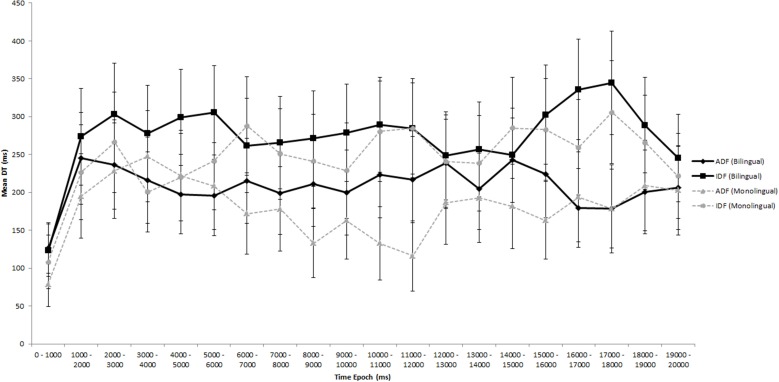
Infants' looking patterns in Experiment 1A. The solid black line represents bilingual infants' looking patterns to the adult-directed face (ADF) and the infant-directed face (IDF); the dotted gray line represents monolingual infants' looking patterns. Error bars represent the 95% confidence interval.